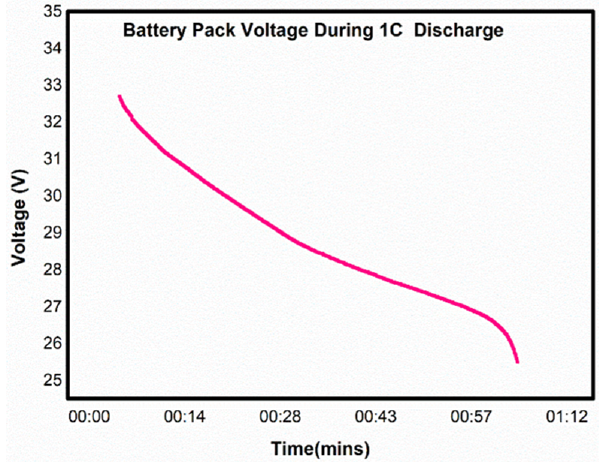
Figure 14. Discharging curve.